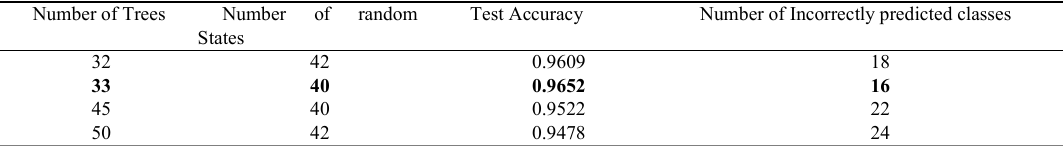
TABLE 11 A NALYSIS OF RF C LASSIFIER (F IG S HARE 3C)